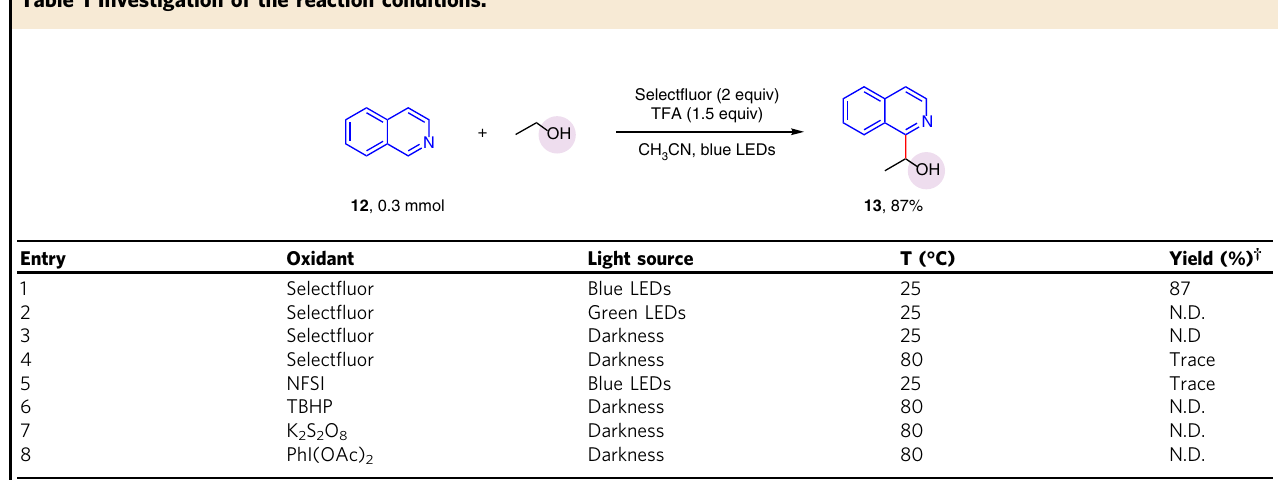
Table 1 Investigation of the reaction conditions.*